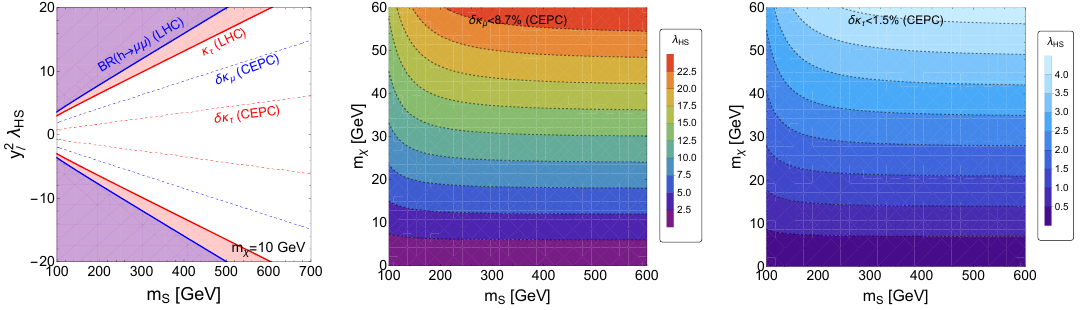
from the h → ‘‘ branching ratio and coupling Figure 9 . Left panel: the constraints on λ HS y 2 ‘ strength κ from existing LHC constraints [97, 98] with fixed DM mass m = 10 GeV. Middle and τ χ right panels: the constraint on λ from the projected precision δκ 8 . 7% and δκ 1 . 5% from HS µ < τ < CEPC [99], with y = y th by DM relic ‘ ‘